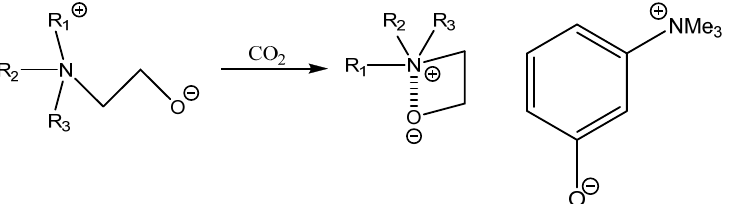
Figure 12. Structure of the most active bifunctional phosphonium salt tri-n-butyl-(2-hydroxyethyl) phosphonium iodide [93].